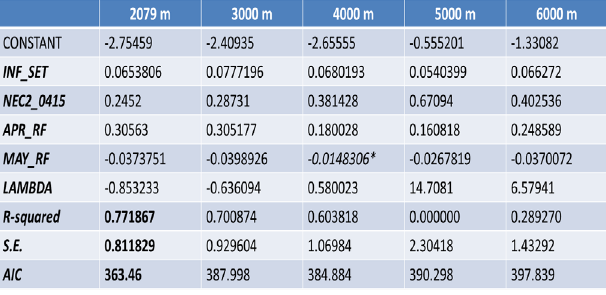
Table 1. SE Models for May 2015 (Low Dengue Case) Using Different Spatial Lag and Weights.